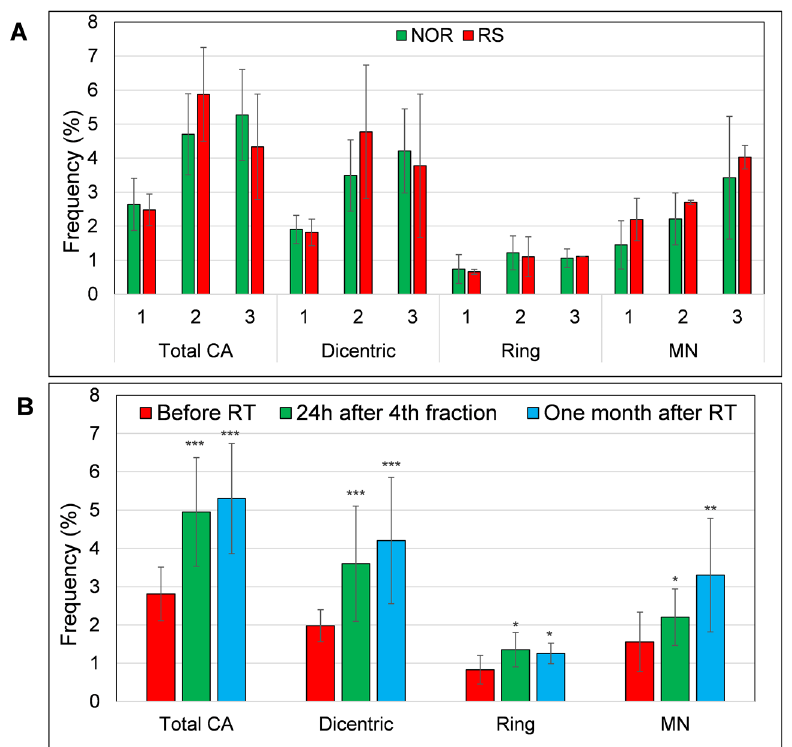
Figure 5. The level of chromosomal aberrations (dicentric, ring chromosomes and total aberrations (summation of dicentrics and rings)) and MN ( A ) in the PBL of RS and NOR patients and ( B ) level of CA and MN in all samples collected before (1), 24h after 4th fraction (2) and one month after RT (3). Frequency of CA and MN was defined as percentage of aberrant cells per 100 metaphases/MN per 100 binucleated cells (1000 metaphases/binucleated cells were analyzed, respectively). Data from 11 NOR and 2 RS patients are shown as mean and standard deviation. p -values are indicated by asterisk (* p ≤ 0.05; ** p ≤ 0.01; *** p ≤ 0.001).